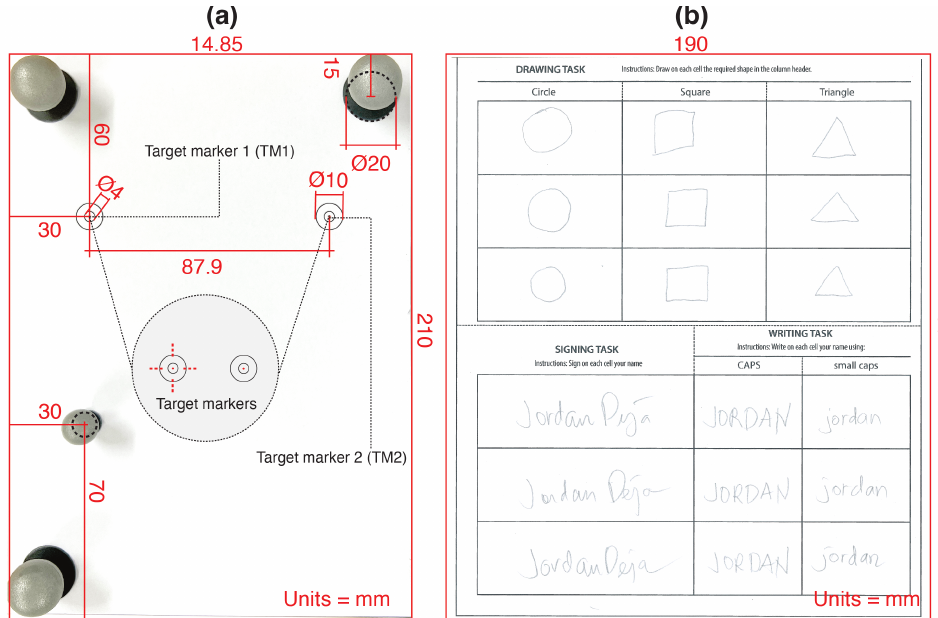
Figure 5. ( a ) A5 size paper used in Study A with two target markers (TM1 & TM2). Participants had to perform a stroke action over these markers to align paper position. One paper had both target markers presented as a cross and the other as a dot. ( b ) Worksheet used in Study B with drawing, signing and writing tasks to evaluate the usability of the Hybrid Stylus as a regular